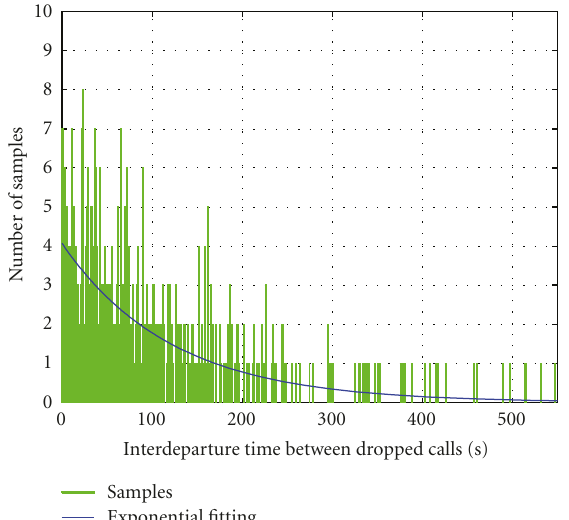
Figure 7: Fitting of interdeparture time between dropped calls with an exponential pdf (cell 1 observed for 24 hours).